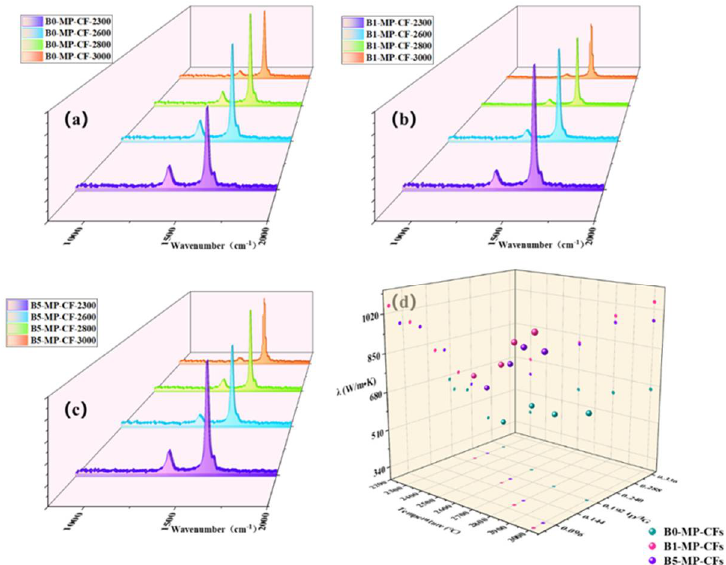
Figure 7. Raman spectra of CFs at different graphitization temperatures of 2300, 2700, 2850, 3000 °C ( a – c ), and scatter plot of CFs at different temperatures, I D /I G and λ ( d ).